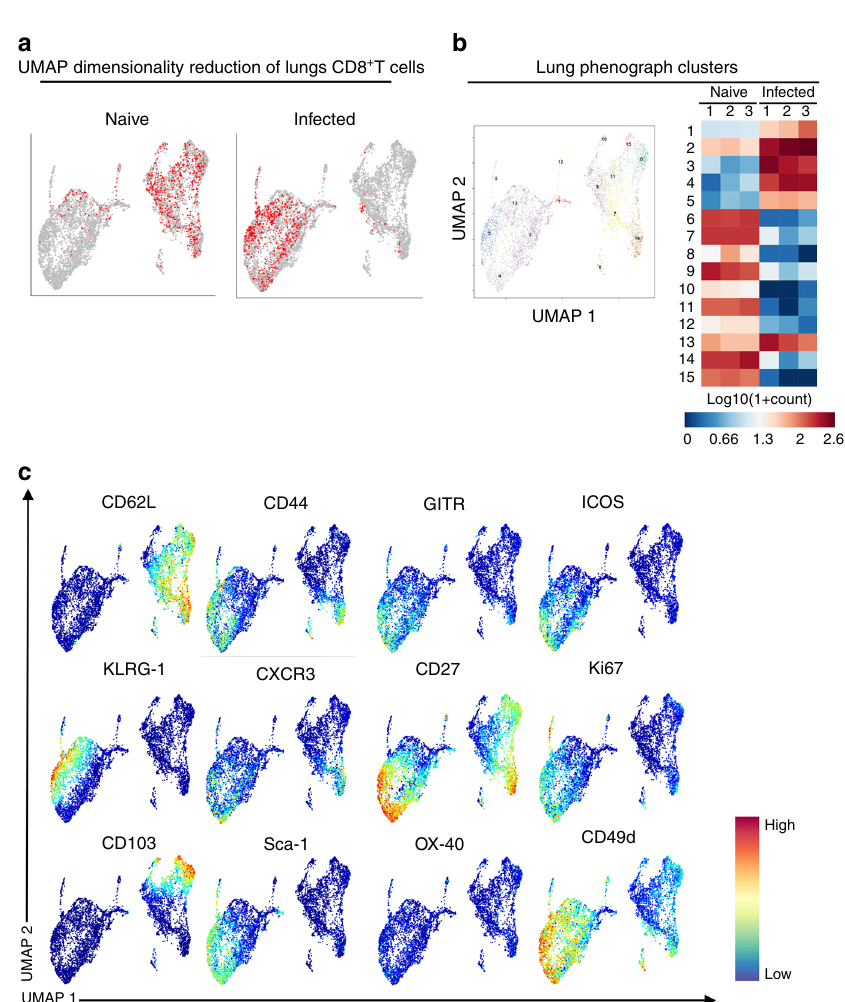
Fig. 3 UMAP dimensionality reduction of CD8 + T cells. a UMAP dimensionality reduction of lung CD8 + T cells isolated from naive ( n = 3) and PbA luc - infected ( n = 3) mice at 7 dpi was color-coded (red dots represents where the CD8 + T cells are located). A representative plot of three mice is shown. b Lung CD8 + T cell clusters segregation by UMAP identi fi ed a total of 15 different clusters. Median expression of lung phonograph clusters across individual samples plotted and summarized as a heat map. c UMAP dimensionality reduction of lung CD8 + T cells color-coded by relative intensity in each channel. The fi gure shows only the highly expressed